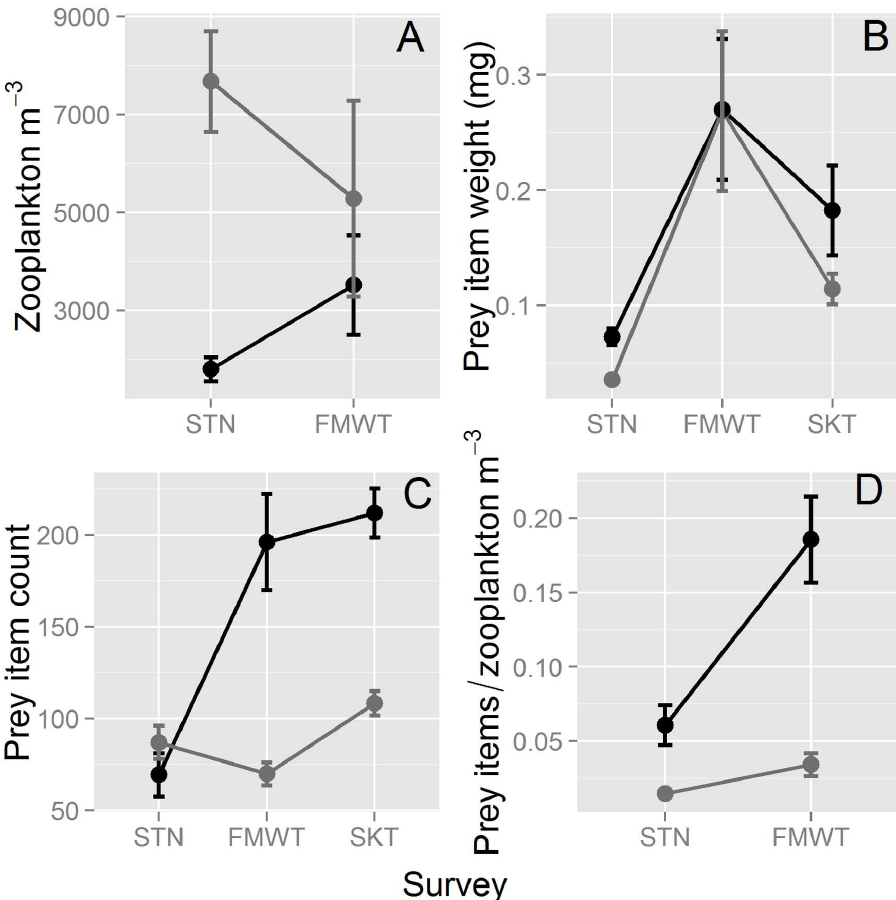
Fig 3. Mesozooplankton abundance and Delta Smelt foraging. Grey is freshwater (mean salinity < 0.55 psu), black is brackish habitat ( (cid:21) 0.55 psu), and error bars are ± SE. (A) mesozooplankton abundanceby survey (collectedconcurrently with Delta Smelt), (B) mean weight (mg) of prey items in Delta Smelt stomachs by survey, (C) mean numberof prey items by survey in Delta Smelt stomachs, and (D) the numberof prey items in Delta Smelt stomachs per mesozooplankton m -3 by survey. STN is the Summer Townet survey (summer), FMWT is the Fall Midwater Trawl survey (fall/winter), and SKT is the Spring Kodiak Trawl survey